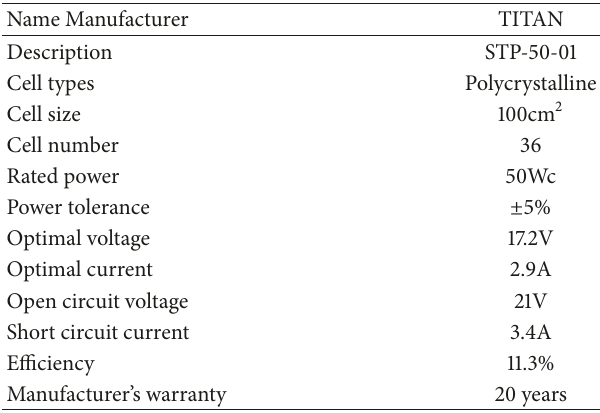
Table 2: Electrical parameters of the solar panel TITAN-12-50.